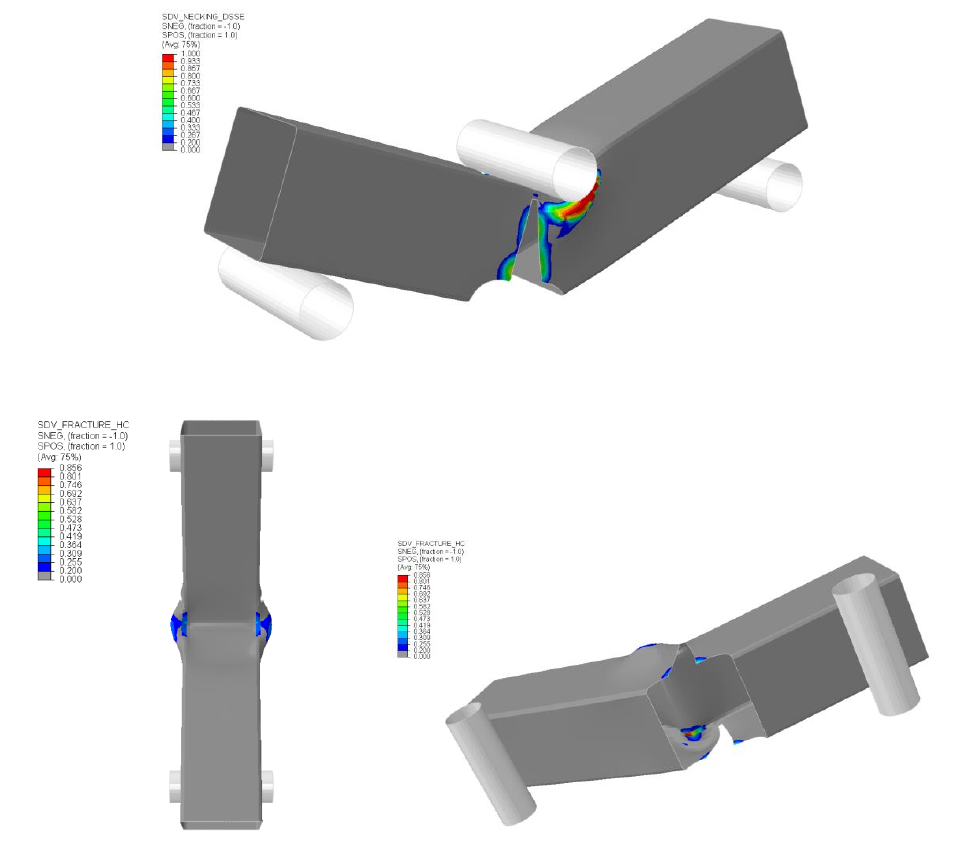
Figure 10. Predicted deformations and fracture in the simulation of the dynamic impact test.